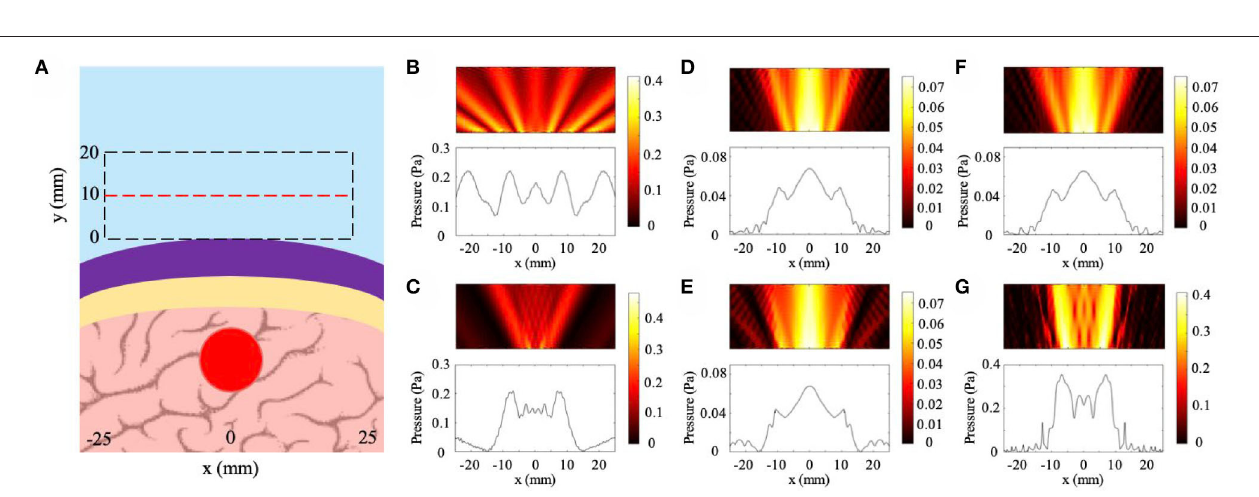
FIGURE 5 | Multi-slope condition. (A) Diagram of the skull/NHCMM condition with the skull slope changing by imaging region, coupled with a uniform 10mm thick NHCMM. (B) Scattered pressure field from the multi-slope skull coupled with a 10mm thick NHCMM. (C) Scattered pressure field from the multi-slope skull with a NHCMM layer that matches the changes in thickness of the skull. The colorbars represent pressure amplitudes in Pa.